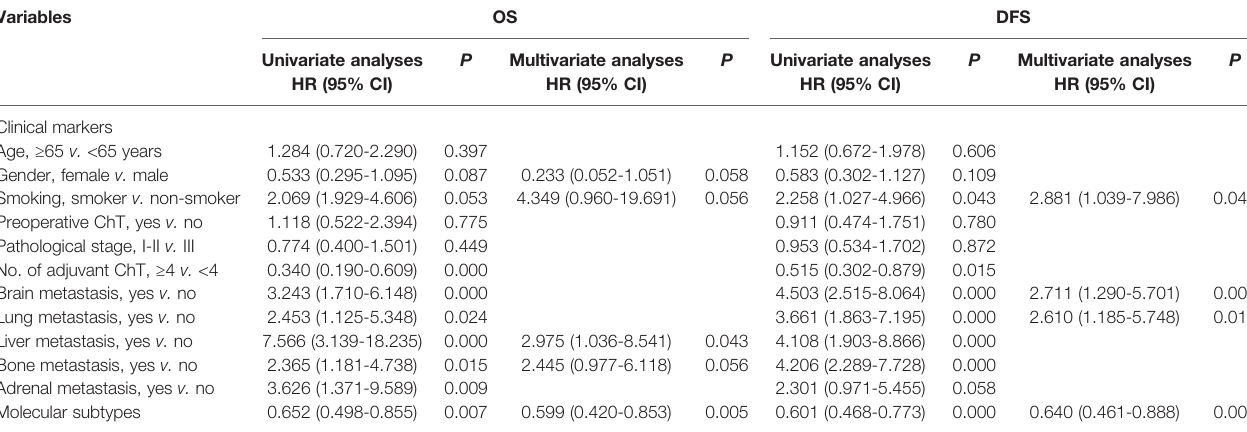
TABLE 4 | Univariate and multivariate analyses for prognostic signi fi cance of clinical features and molecular subtypes in patients with primary small cell lung cancer. Variables